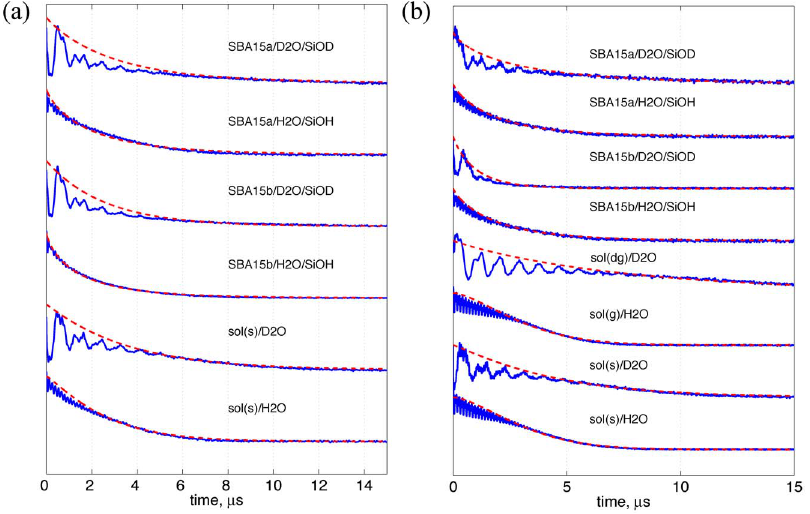
Figure 5. Long-range water accessibility study by ESE. The theoretical fits (red lines) to the ESE experimental data (blue lines) using a stretched exponential function (see Table 1) as previously described. [11] The results for the n3 b -s and PPm3-s are shown in (a) and (b), respectively. The decay signals acquired by the ESE experiments were fitted over the maxima of the deuterium modulation as described in Zecevic et al. [32] to minimize the influence from destructive interference of nuclear modulations. The obtained values of the T M (in ns) and stretching exponent x are shown in Table 1. The T M values can be directly used to yield the surrounding proton density ( C ex ; cf. Eq. 2) within the range of , 2 nm from a nitroxide spin.